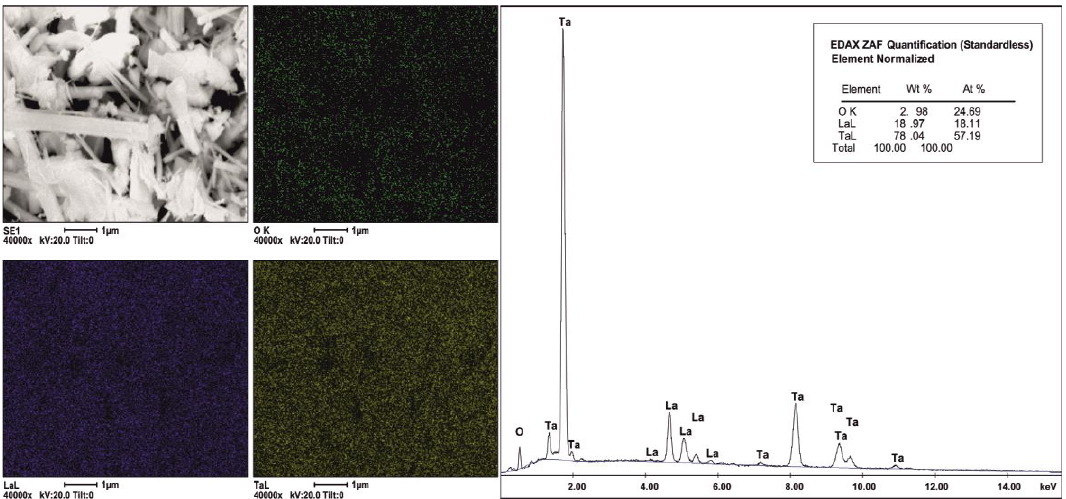
Figure 4. SEM-EDS elemental mapping images of HLaTa_01 protonated perovskite for La, Ta and O elements.